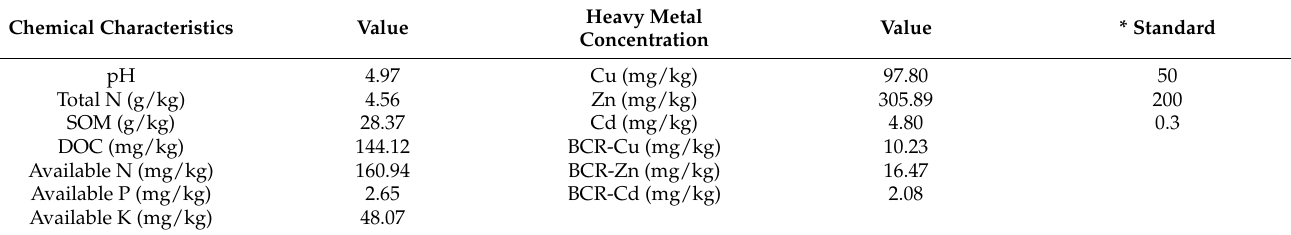
Table 1. The soil chemical characteristics and heavy metal concentrations in the soil. Chemical